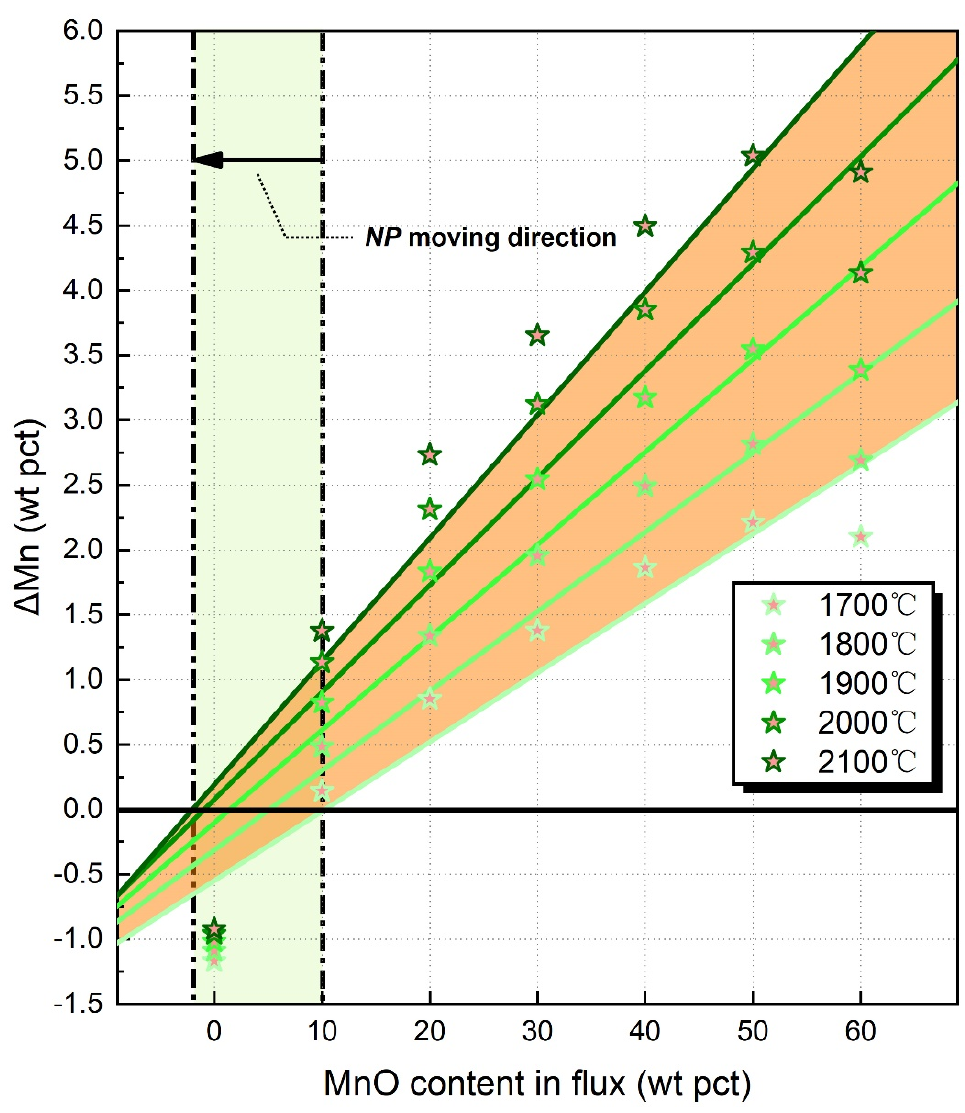
Figure 2. The NPs calculated by slag-metal equilibrium model: the star-points indicate the predicted ∆ Mn values subject to various EET.